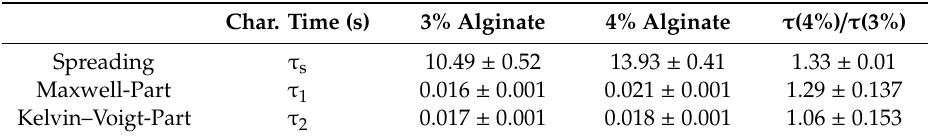
Table 7. Resulting characteristic times for 3% and 4% Alginate solutions concerning spreading and Burgers model.